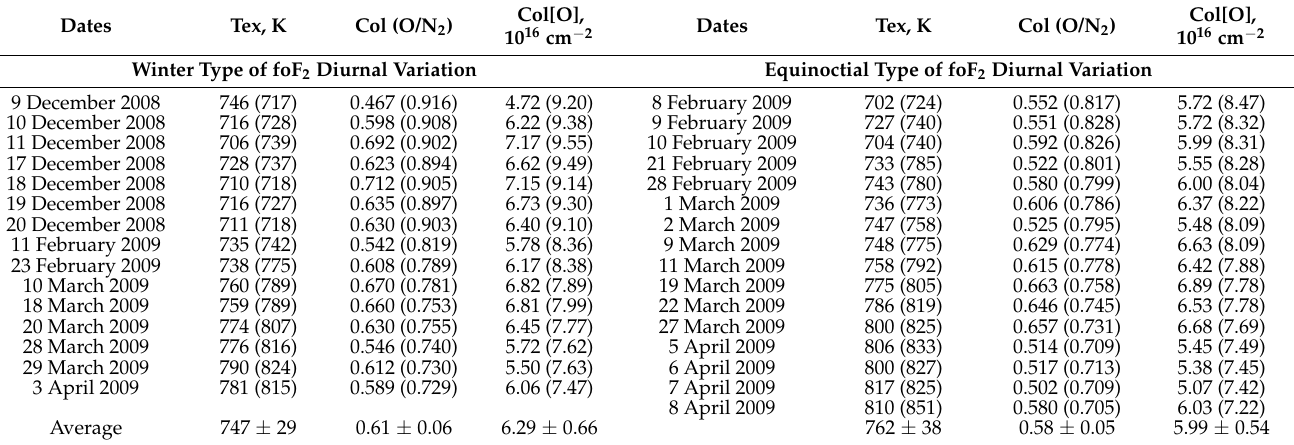
Figure 6. Retrieved noontime column O/N 2 ratio and vertical plasma drift W at Boulder for days with winter and vernal equinox foF 2 diurnal variations. Table 2. Retrieved thermospheric parameters for winter and vernal periods at Boulder. Numbers in brackets—MSIS86 model values.